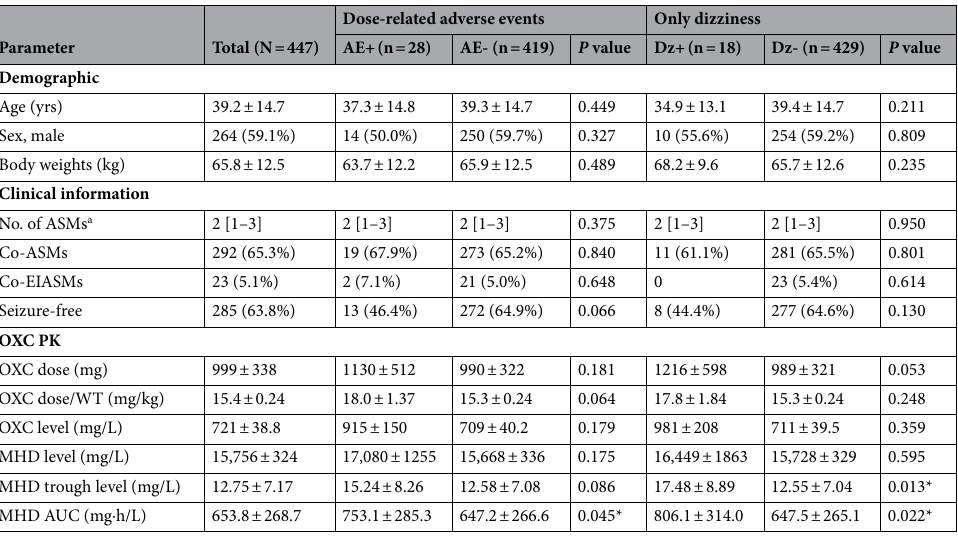
Table 1. Characteristics of patients taking oxcarbazepine according to the occurrence of dose-related adverse events. Values are mean ± SD or number (%). AE + patients with dose-related adverse events, AE− patients without dose-related adverse events, WT body weight, Dz + , patients with only dizziness, Dz− patients without only dizziness, ASMs antiseizure medications, Co-ASMs existence of concomitant ASMs, Co-EIASMs existence of concomitant enzyme-inducing ASMs (≤ 6), OXC oxcarbazepine, PK pharmacokinetics, MHD Monohydroxy derivative of oxcarbazepine, AUC area under the plasma concentration–time curve. * P < 0.050. a Values in median [interquartile range]. Statistical analysis: Fisher exact test or Mann–Whitney’s U